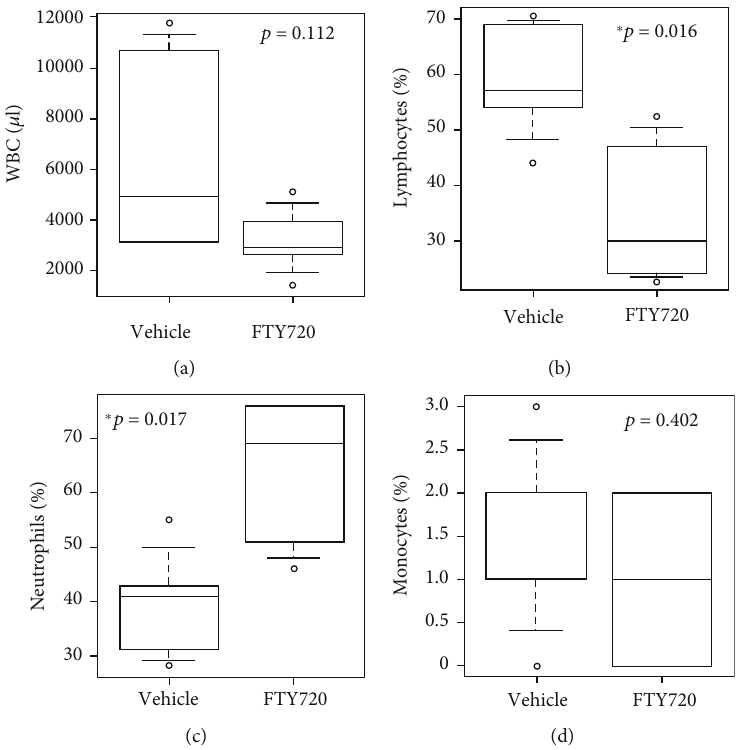
Figure 6: The e ff ects of topical FTY720 injection on the number of total white blood cells and white blood cell types on Day 14. (a) The number of white blood cells, as determined by total blood cell counting. The frequencies of lymphocytes (b), neutrophils (c), and monocytes (d) in the blood. All values shown represent means ± s : e : m : ( n = 7 ). Two independent experiments were performed. Both showed similar results. ∗ p < 0 : 05 , as determined by Student ’ s t -test or Welch ’ s t -test after F